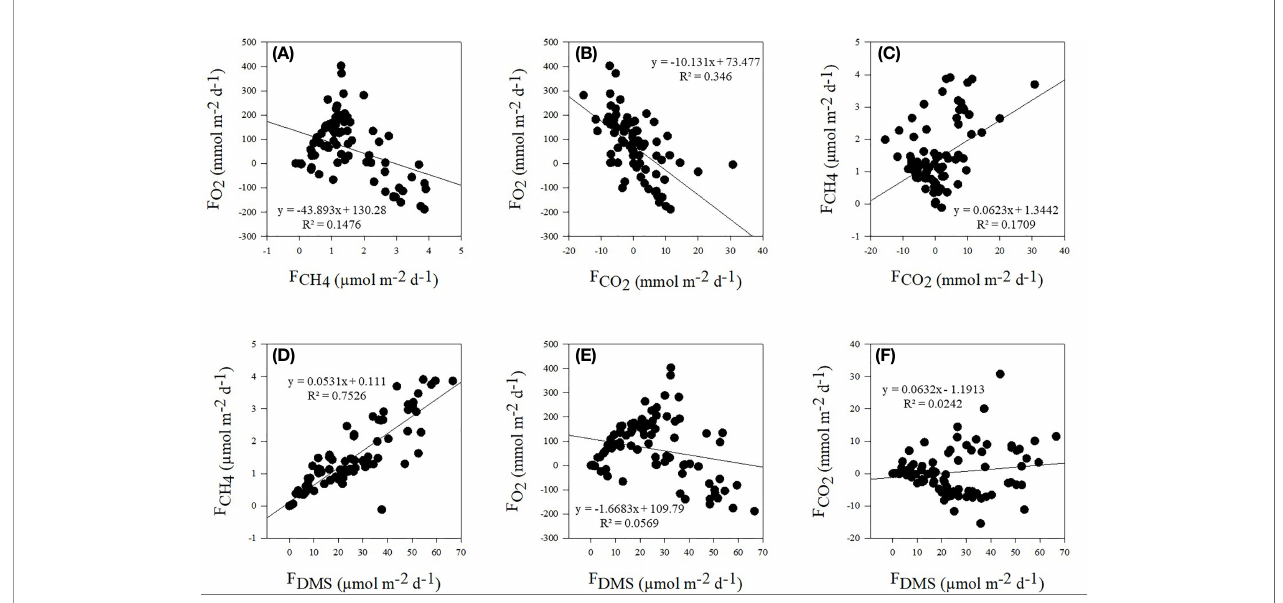
FIGURE 2 | Correlations between sea-to-air fl uxes of CH 4 and O 2 (A) , CO 2 and O 2 (B) and CO 2 and CH 4 (C) as well as between fl uxes of DMS and CH 4 (D) , O 2 (E) and CO 2 (F) . Trendlines, regression equation and R 2 values are displayed for each